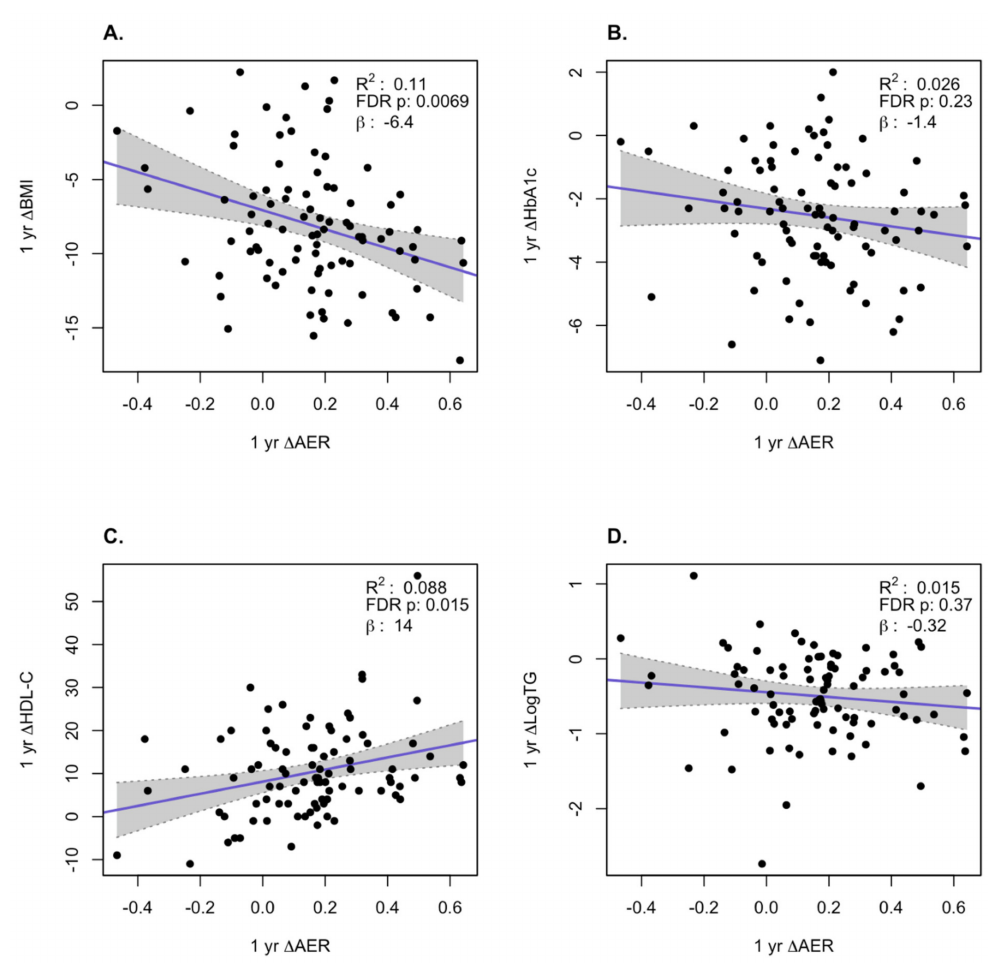
Figure 2. Correlation of changes of apoA1 exchange rate assay (AER) with changes in clinical variables at 1 year. Changes in BMI ( A ), HbA1c ( B ), HDL-C ( C ), and log TG ( D ). The gray region is the 95% confidence